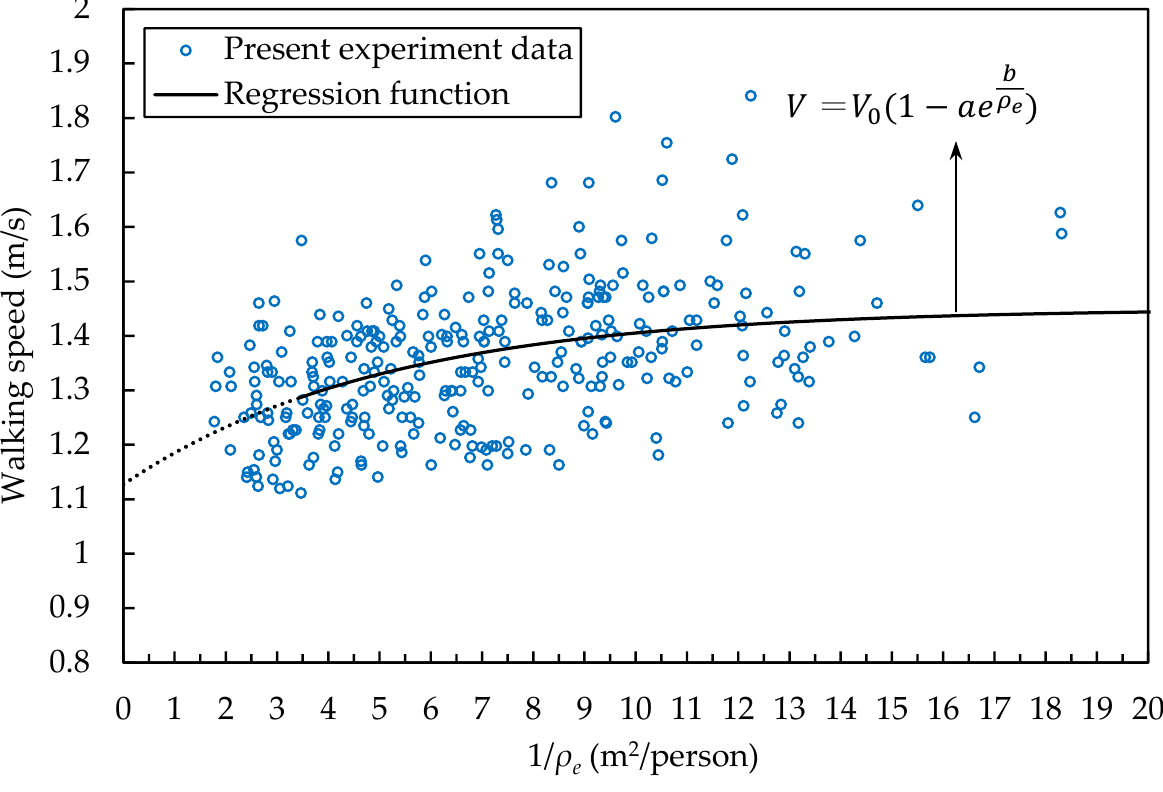
Figure 10. Relationship between speed and personal area module. Parameters a and b in Equation (4) were estimated through a nonlinear regression by applying the least square method. The regression curve is shown as a black line